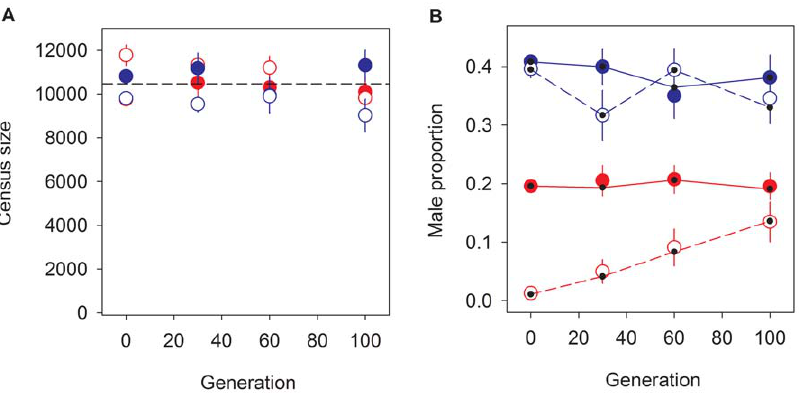
Figure 4. Evolution of sex ratios. In A , the census size at the adult stage is shown for dioecious (blue), or androdioecious (red) populations. Empty circles stand for populations without initial diversity; filled circles indicate populations with initial standing diversity. Average values are shown with associated standard error of the mean (SEM) among replicates. Dashed line indicates the overall least-square estimate irrespective of mating system or initial condition of genetic diversity (see Table 1 for analysis). In B , the male proportions measured in all 24 populations (symbols as in A ). Lines join the least-square estimates by generation at each treatment (dots). doi:10.1371/journal.pone.0035811.g004 tained males at 19.6% throughout the experiment. On the other ( Figure 4B ). Note that due to high sampling error the sex ratio hand, inbred background populations showed a consistent increase change in androdioecious populations without initial diversity was in male numbers, from initial absence to 13.6% by generation 100 only marginally significant (3-way interaction term in Table 1 ; see